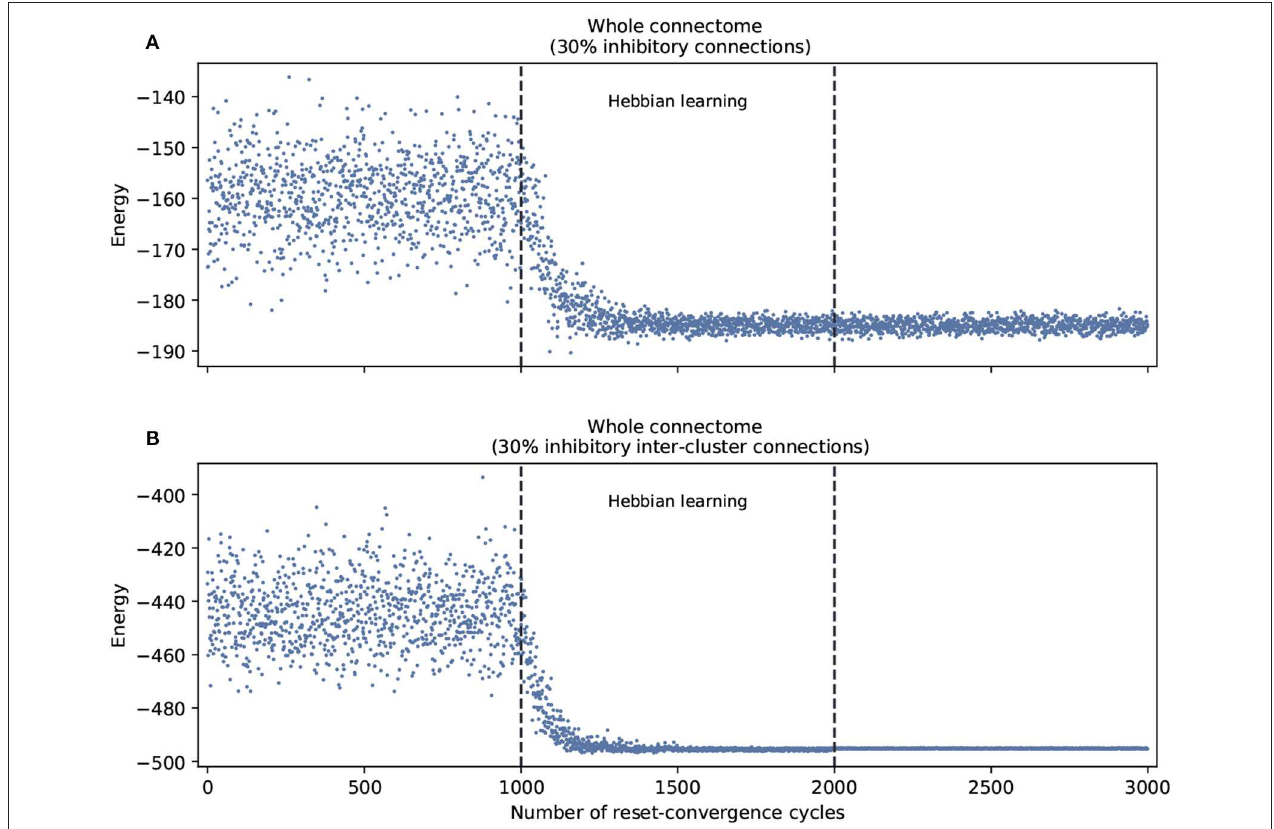
FIGURE 3 | Self-optimization tested in the whole connectome with two different scenarios. (A) With 30% inhibitory connections arbitrarily assigned at the beginning of the process. (B) With 30% inhibitory connections arbitrarily assigned only in the inter-cluster connections at the beginning of the process. Each panel was averaged from 10 different experiments and shows the energy of the neuron states in three distinct phases: before learning (1–1,000), during the self-optimization process (1,001–2,000), and after learning (2,001–3,000). Both scenarios tend to self-optimize, but the algorithm explores a broader variety of attractors and converges on more optimal patterns of coordination when inhibitory connections are restricted to inter-cluster